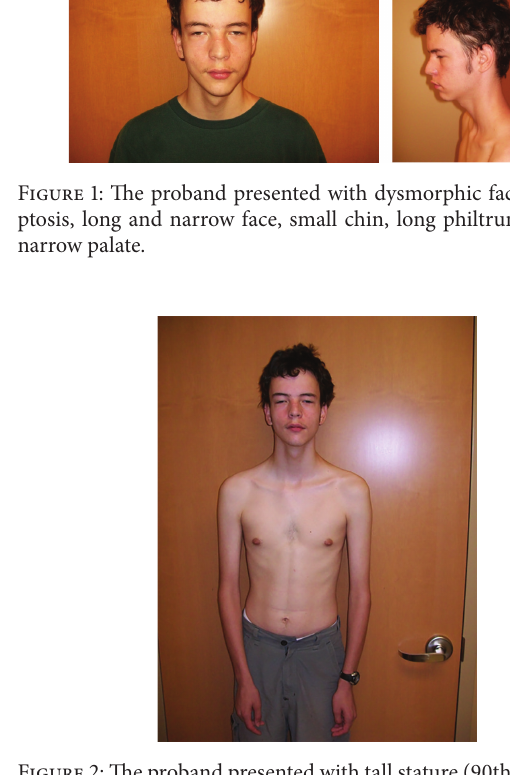
Figure 2: The proband presented with tall stature (90th percentile), low weight (10–25th percentile), marfanoid habitus, long fingers, hypermobile joints, mild scoliosis, and pectus